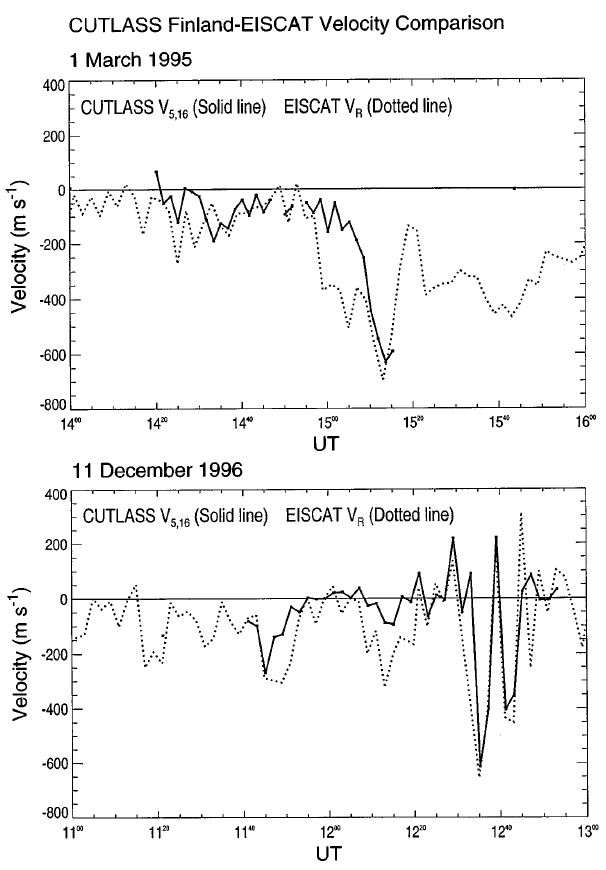
Fig. 4. EISCAT CP-2 and CUTLASS Finland velocity measure- Fig. 3. EISCAT CP-1 and CUTLASS Finland velocity measure- ments from 1200 to 1400 UT on 20 March, 1996. The Four panels , ments from 1400 to 1600 UT on 1 March, 1995 ( upper panel ) and from the top, illustrate, as solid lines , the line-of-sight irregularity drift from 1100 to 1300 UT on 11 December, 1996 ( lower panel ). Each velocities measured by the Finland radar in range gate 14 of beam 7, panel illustrates the CUTLASS velocity spatially coincident with the range gate 14 of beam 5, range gate 16 of beam 5 and range gate 17 of location of tristatic EISCAT measurements ( V : solid line ,) and beam 5; these range cells correspond to the locations of the tristatic 5,16 the component of the EISCAT velocity resolved along the direction of volumes of each of the four pointing directions of CP-2 (see Table 1). the CUTLASS beam within range gate 16 of beam 5 ( V : dotted line ); In each panel, the component of the tristatic ion velocity, resolved R again positive velocities indicate motion towards the Finland radar along the CUTLASS Finland radar beam within that range cell ( V is represented by a dotted line. As in previous figures, positive along the Finland beam ( V : dashed line); again positive velocities are those directed towards the R velocities are towards the Finland radar.